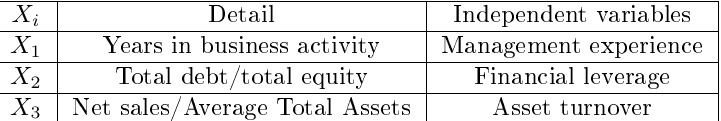
Table 3. Variables of the second sample.